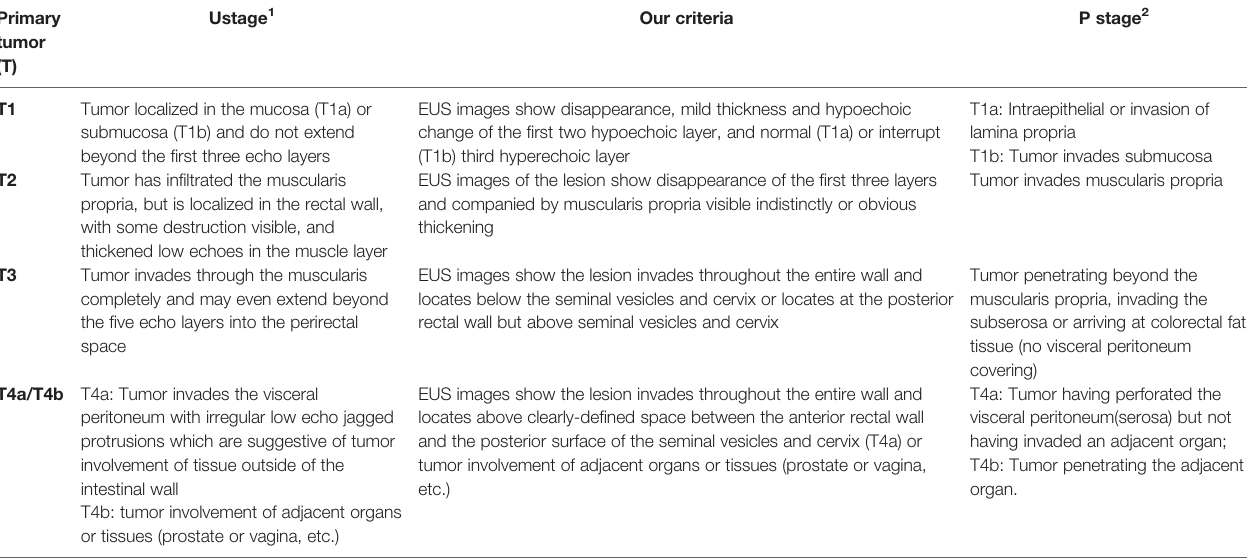
TABLE 1 | The EUS features and AJCC 7th/8th staging system for primary colorectal cancer. Primary tumor